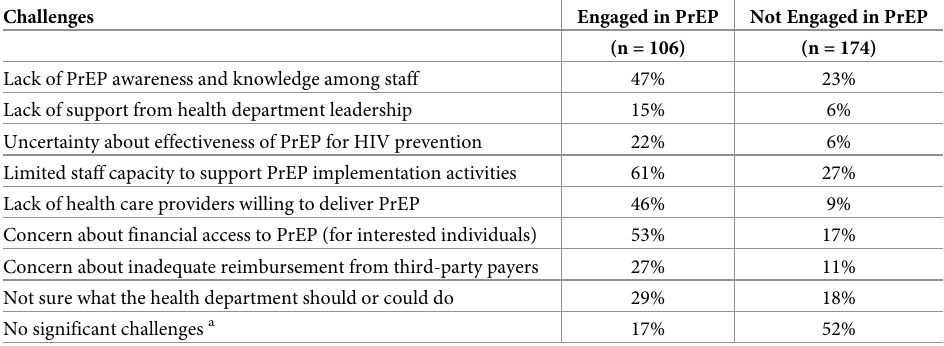
Table 3. Challenges to PrEP implementation for local health departments, United States, 2015, weighted response